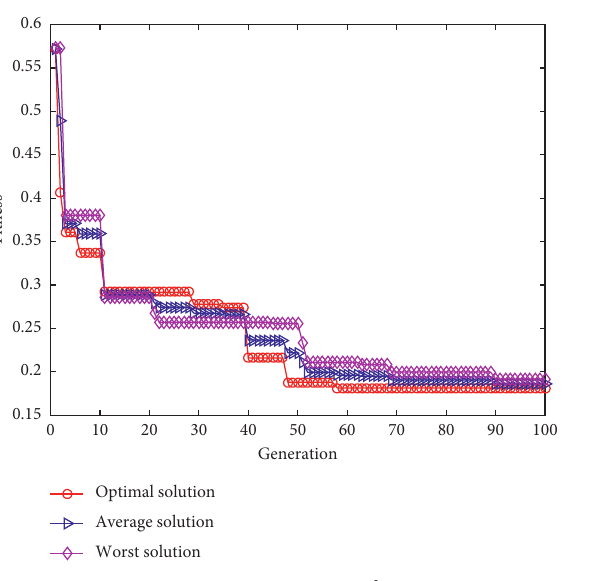
Figure 14: MAC matrix of